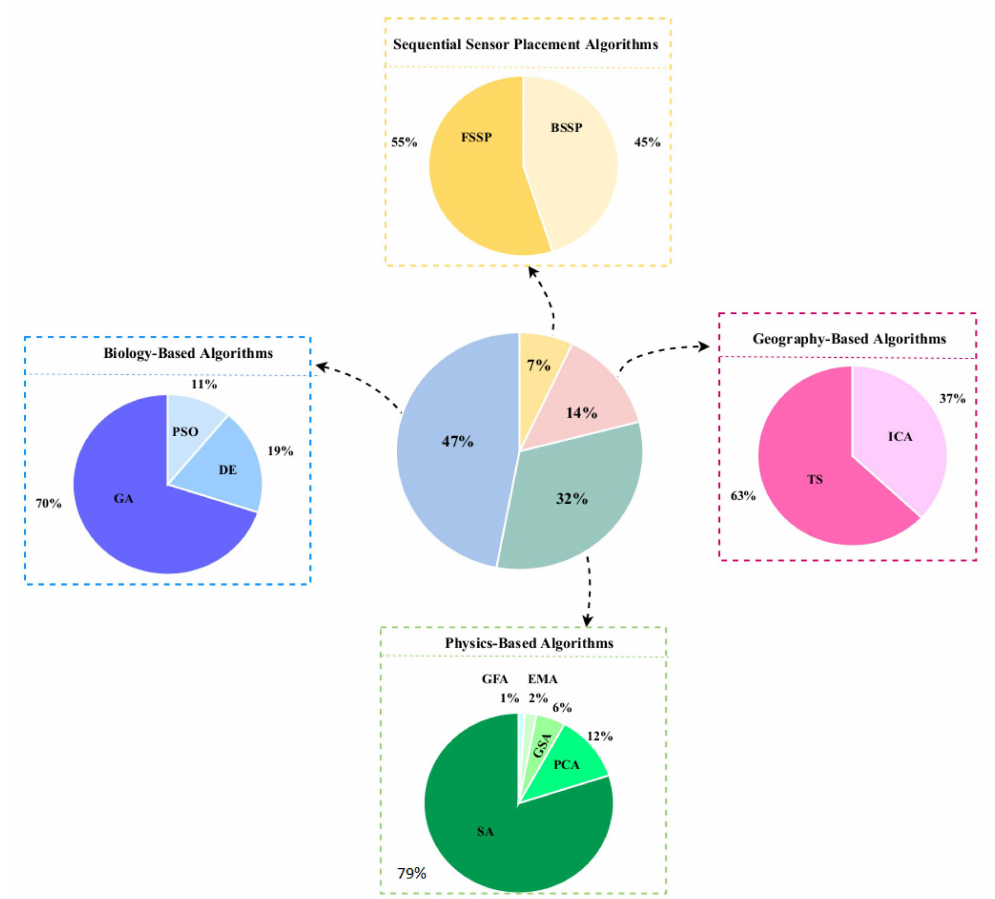
Figure 10. Pie charts of applications of optimization algorithms in SHM.